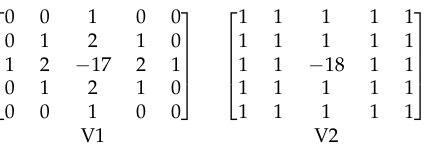
Figure A5. Laplace discrete approximation masks 5 × 5.